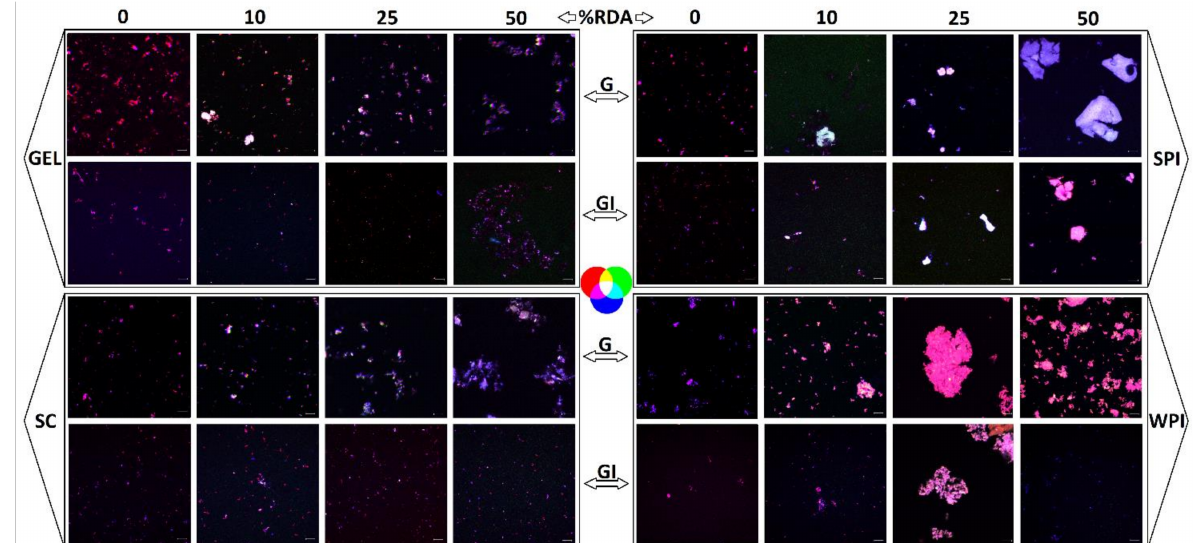
Figure 5. Images taken after gastric (G) and GI digestion with whey protein isolate (WPI), soy protein isolate (SPI), sodium caseinate (SC), and bovine gelatin (GEL). The grey bar equals 10 µ m. Confocal imaging of emulsion structures was carried out at room temperature with a confocal laser scanning microscope (Zeiss LSM 880, Airyscam SR, Jena, Germany), using a 63 × objective. Fluorescent dyes were excited by an Ar laser (488 nm), and the emitted light was collected at 522 nm for protein and 635 nm for the fat phase. Lipids were labelled with Nile red (red colour) and proteins were labelled with fluorescent isothiocyanate (FITC, green colour), while carotenoids are naturally fluorescent (blue colour).